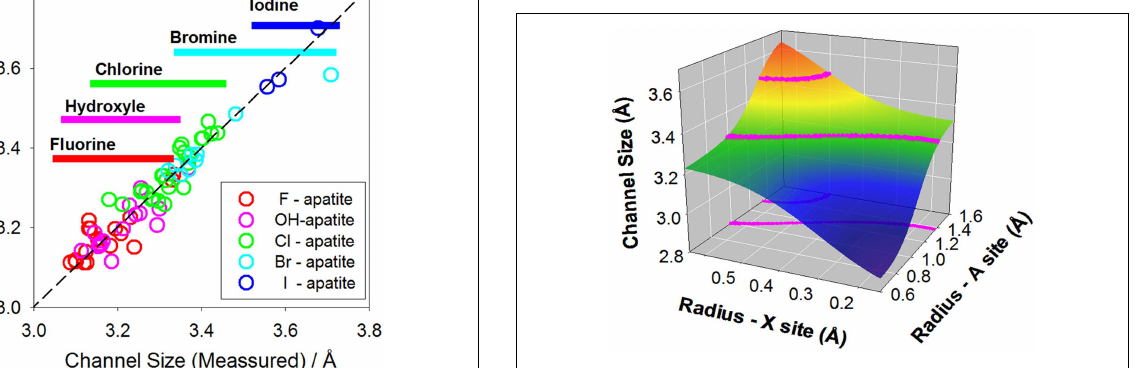
correspond to Y = T when the predicted and actual are the same. The solid lines correspond to linear fitting with a fitting coefficient of R. Open circles are experimental data. (A,B) are the result of training, (C,D) are of testing, and (E,F) are of the total.